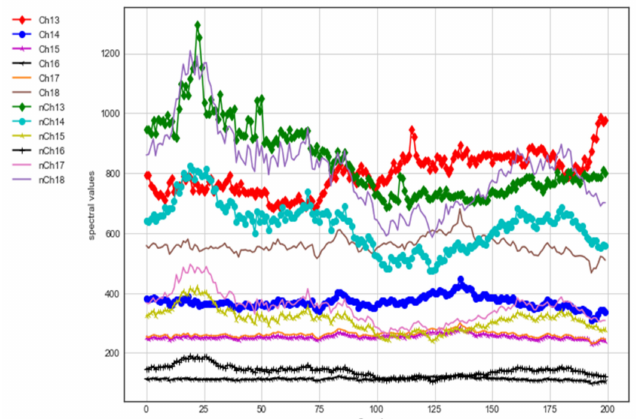
Figure 9. NIR-VIS (730–940 nm) photon count response of organic and conventional brinjal